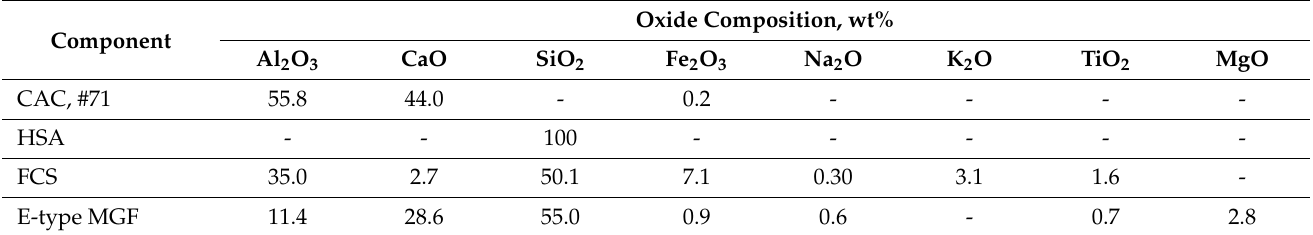
Table 1. Oxide compositions of starting